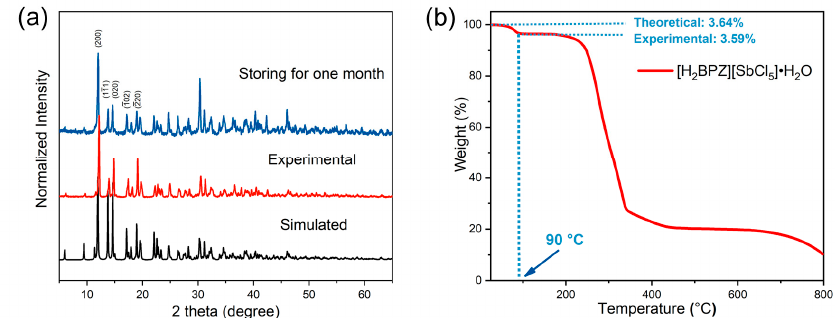
Figure 5. ( a ) The experimental PXRD patterns for as-made [H 2 BPZ][SbCl 5 ]•H 2 O and that storing at ambient conditions for one month compared with the one simulated from SCXRD data. ( b ) The TG curve for [H 2 BPZ][SbCl 5 ]•H 2 O; the theoretical and experimental weight losses of water molecules in the crystal lattice were calculated and labelled.